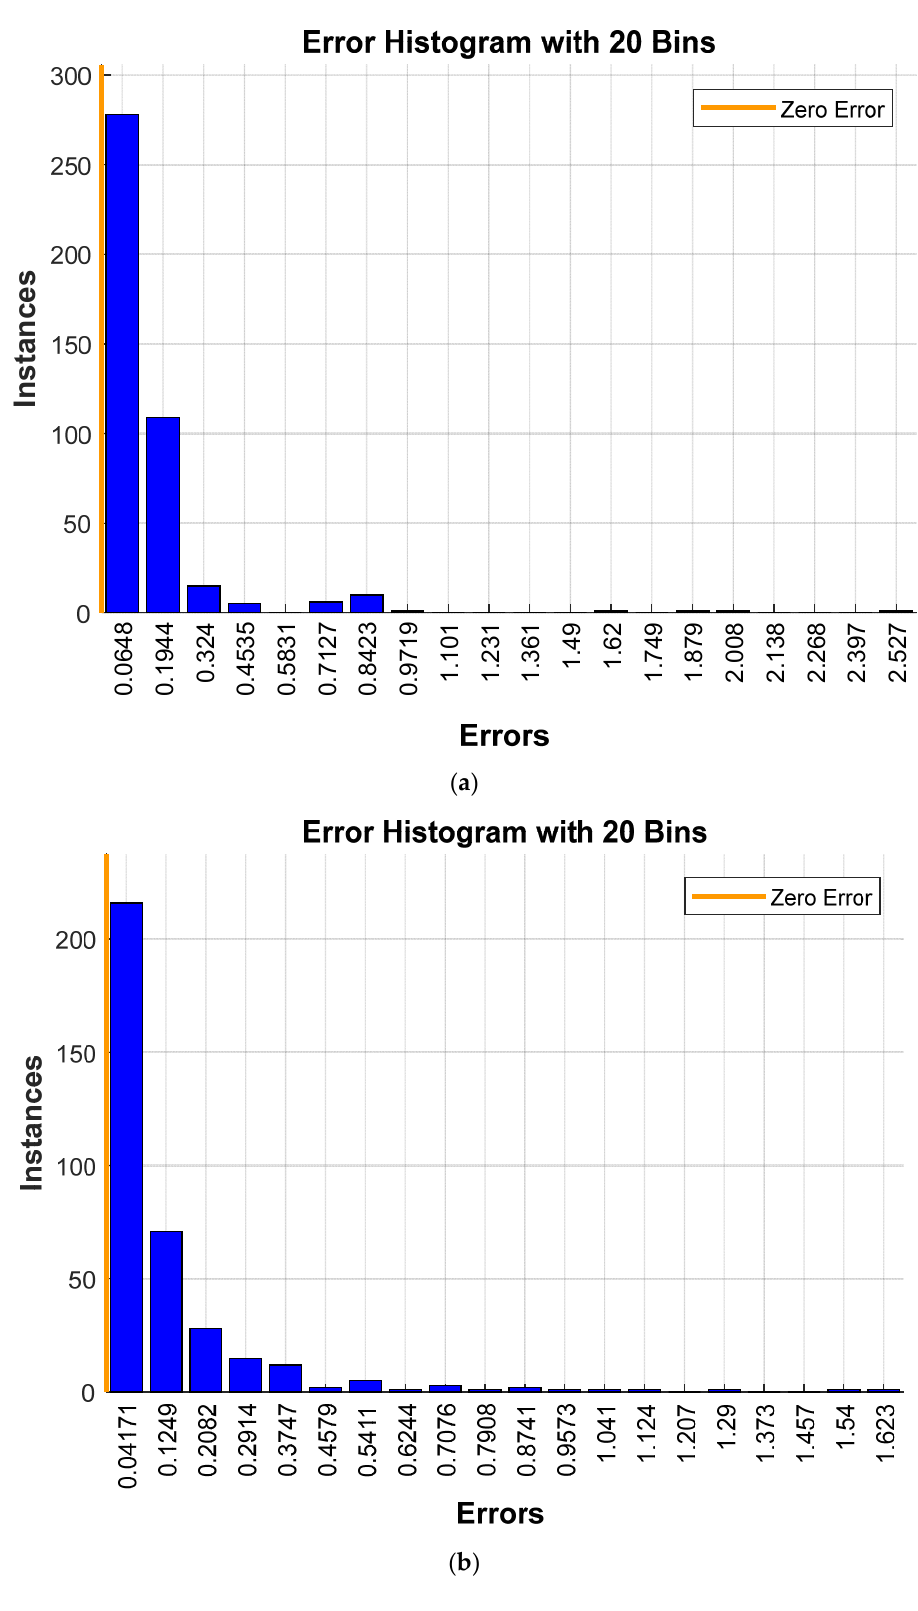
Figure 8. Error histograms for the SVM model in cast-in-place tunnel liners and concrete portal. ( a ) Cast-in-place tunnel liners. ( b ) Concrete portal.